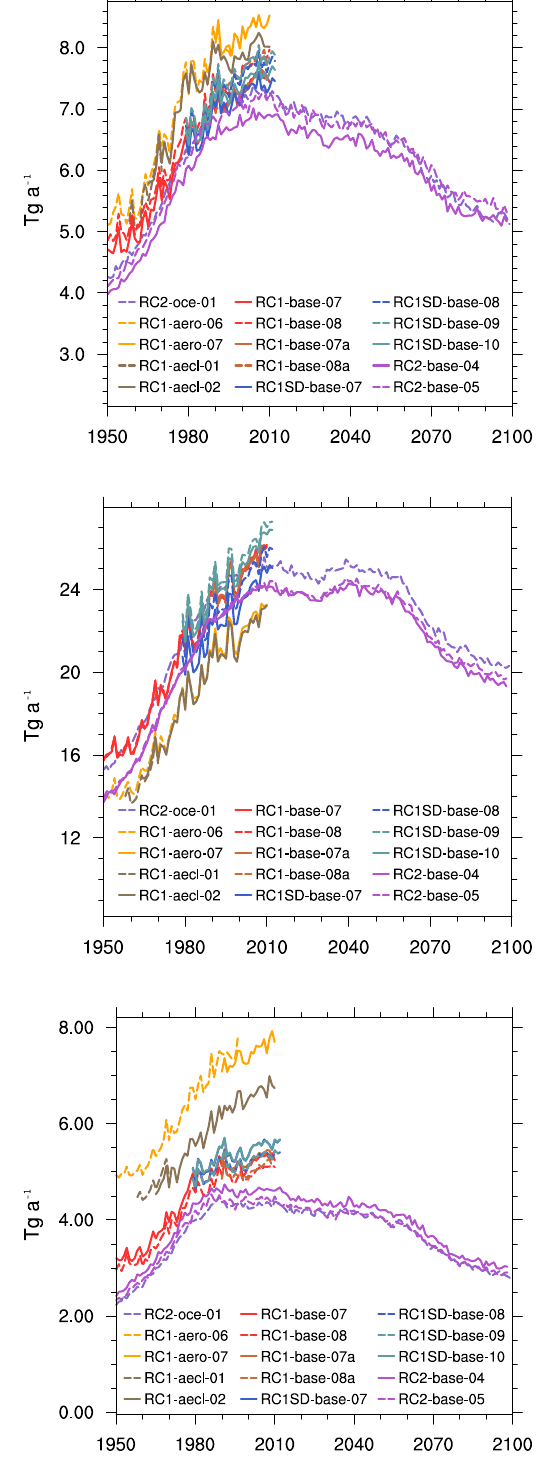
Figure 16. Globally integrated annual nitrate dry deposition (up- per), wet deposition (middle), and sedimentation (lower) fluxes in Tg ( N ) a − 1